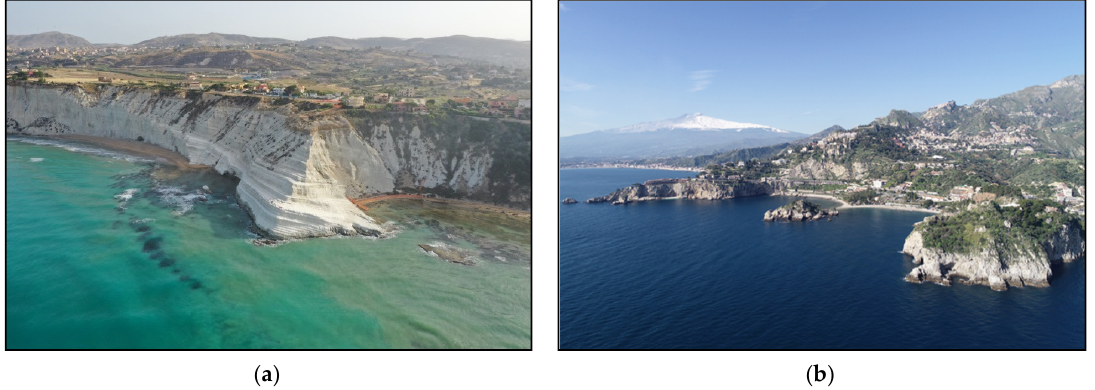
Figure 3. Spectacular cliff views by drone: at ( a ) Scala dei Turchi and at ( b ) Taormina Bay (with the snowy Etna volcano on background).